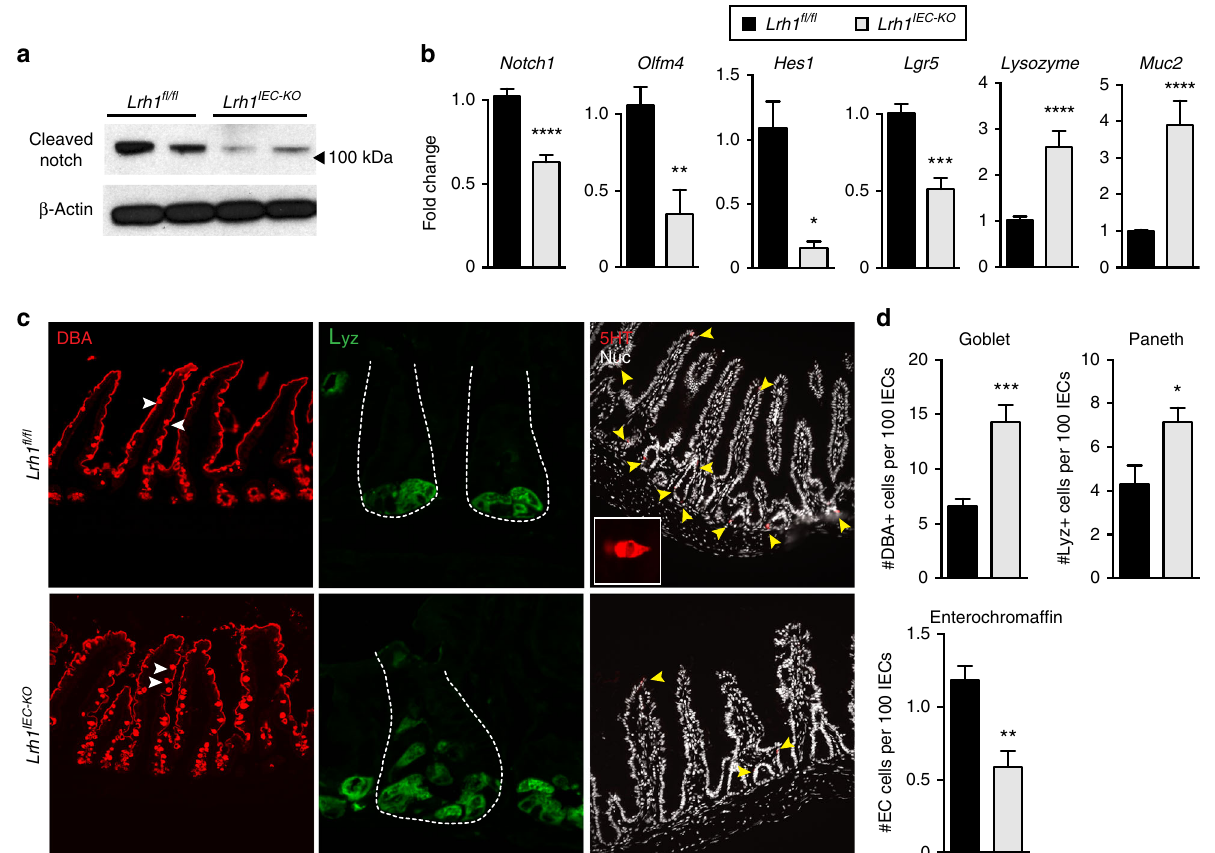
Fig. 2 Lrh1 IEC-KO mouse organoids have diminished Notch activation. a Representative immunoblot for cleaved Notch1 in Lrh1 fl / fl (left two lanes) and Lrh1 IEC- KO (right two lanes), n = 4 per condition. b Fold change in expression by RT-qPCR in Lrh1 fl / fl (black) and Lrh1 IEC-KO (gray) organoids for Notch1 and the Notch target genes Olfm4 and Hes1 . Relative expression of the stem cell marker Lgr5 , Paneth cell marker Lysozyme , and goblet cell marker Mucin2 are also shown. Minimum of three replicates per condition. c Histology of Lrh1 fl / fl and Lrh1 IEC-KO small intestine showing goblet (DBA, red, left), Paneth (lysozyme, green, middle) and enterochromaf fi n cells (5HT, red, right and inset). Scale bar = 50 μ m. Intestinal crypts are outlined with dashed white line in middle panel. d Quantitation of epithelial subtype distribution, n = 3 animals per condition. For b and d , error bars are SEM using Student ’ s t test (unpaired, two tailed) with p values of * p = < 0.05, ** p = < 0.01, *** p = < 0.001, and **** p = <